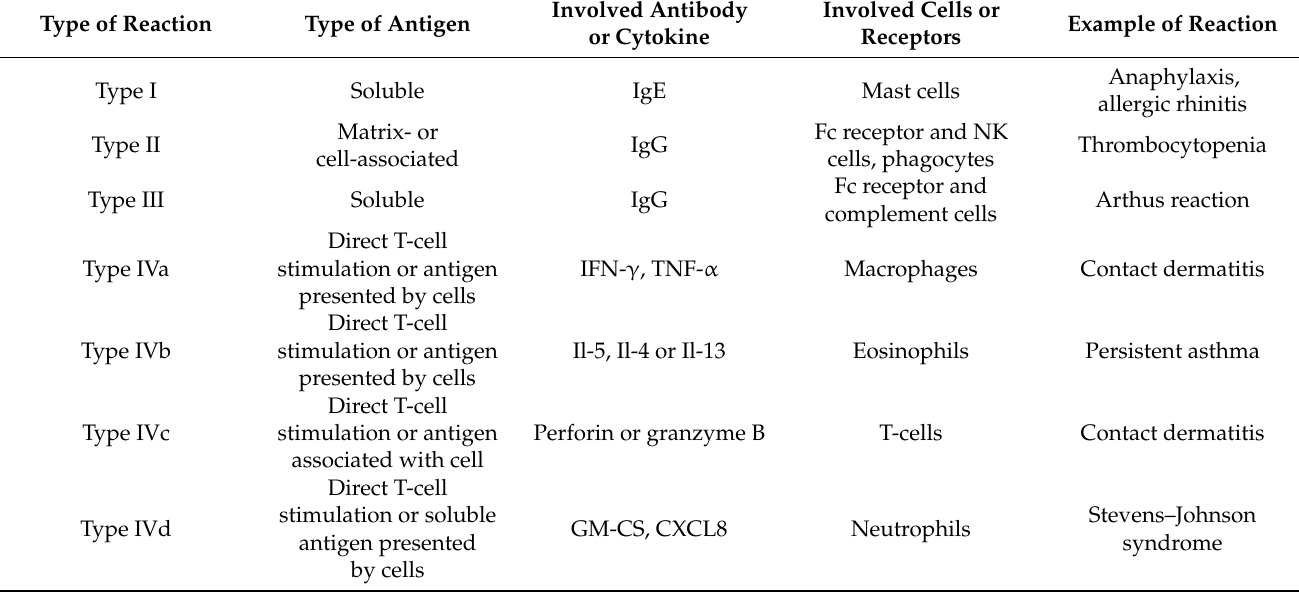
Table 1. Types and characteristics of hypersensitivity reactions Own elaboration based on